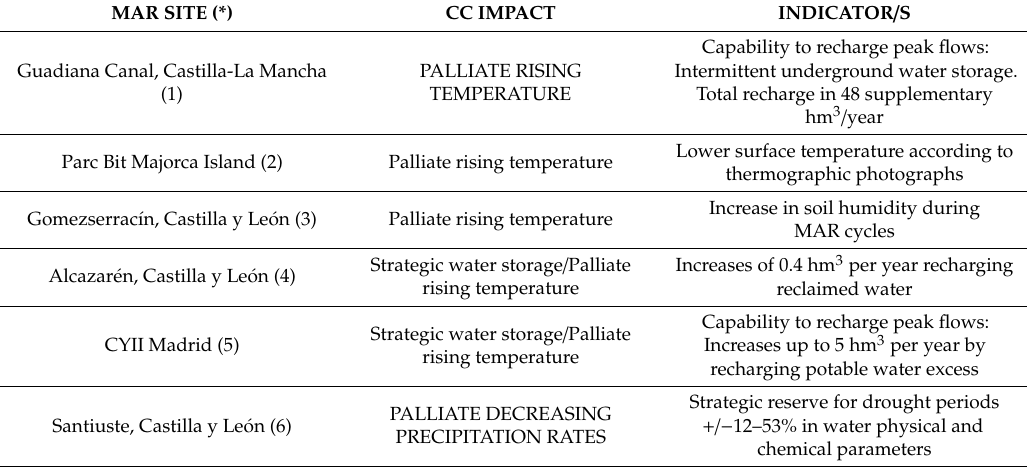
Table 1. Selected Spanish MAR sites and indicators to track their relationship with CC adverse